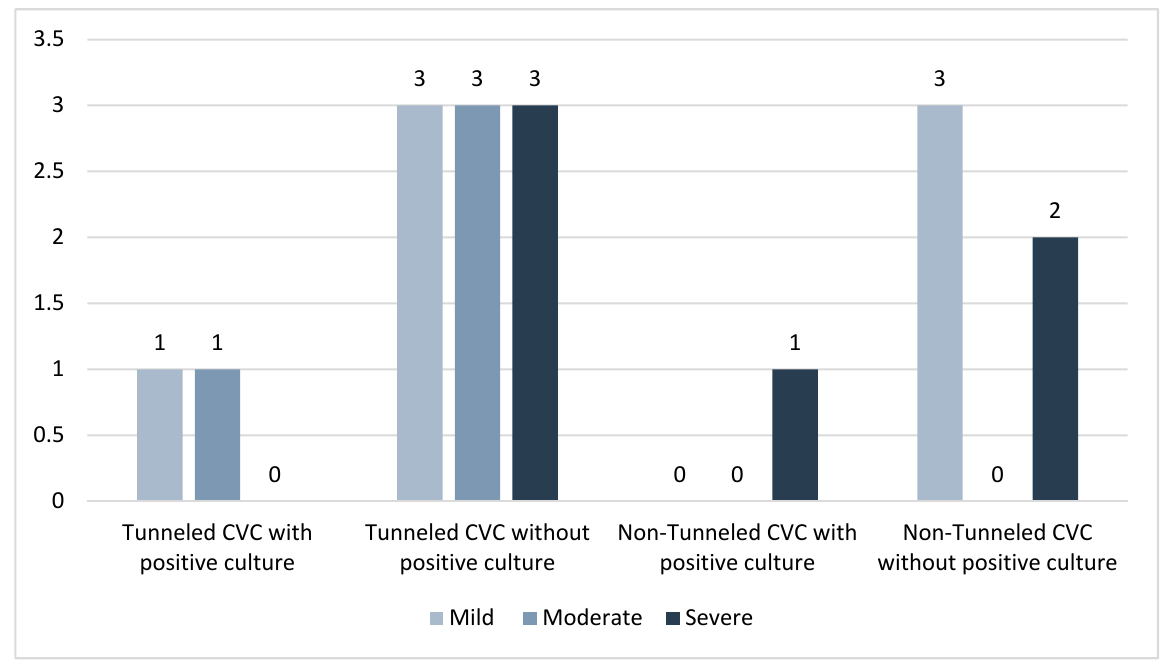
Figure 1. Documented bleeding events after line placement. There were 16 patients that died within 90 days following catheter placement. Of these patients, it was documented that four deaths were a result of bacteremia, with two having had a tunneled CVC, and two a non-tunneled CVC (Figure 2). The remainder of the deaths were documented as unrelated to the placement of the CVC or of unknown cause. No patients died within 24 h of catheter placement. Of note, 66.7% of patients with non-tunneled CVCs and subsequent positive blood cultures died within the study period, while only 10.5% of patients with tunneled CVCs and subsequent positive blood cultures died; however, this was not statistically significant ( p = 1.0). The rate of death from all patients with bacteremia was 25%, compared with those without bacteremia at 6.58%, which was statistically significant p = 0.0015.